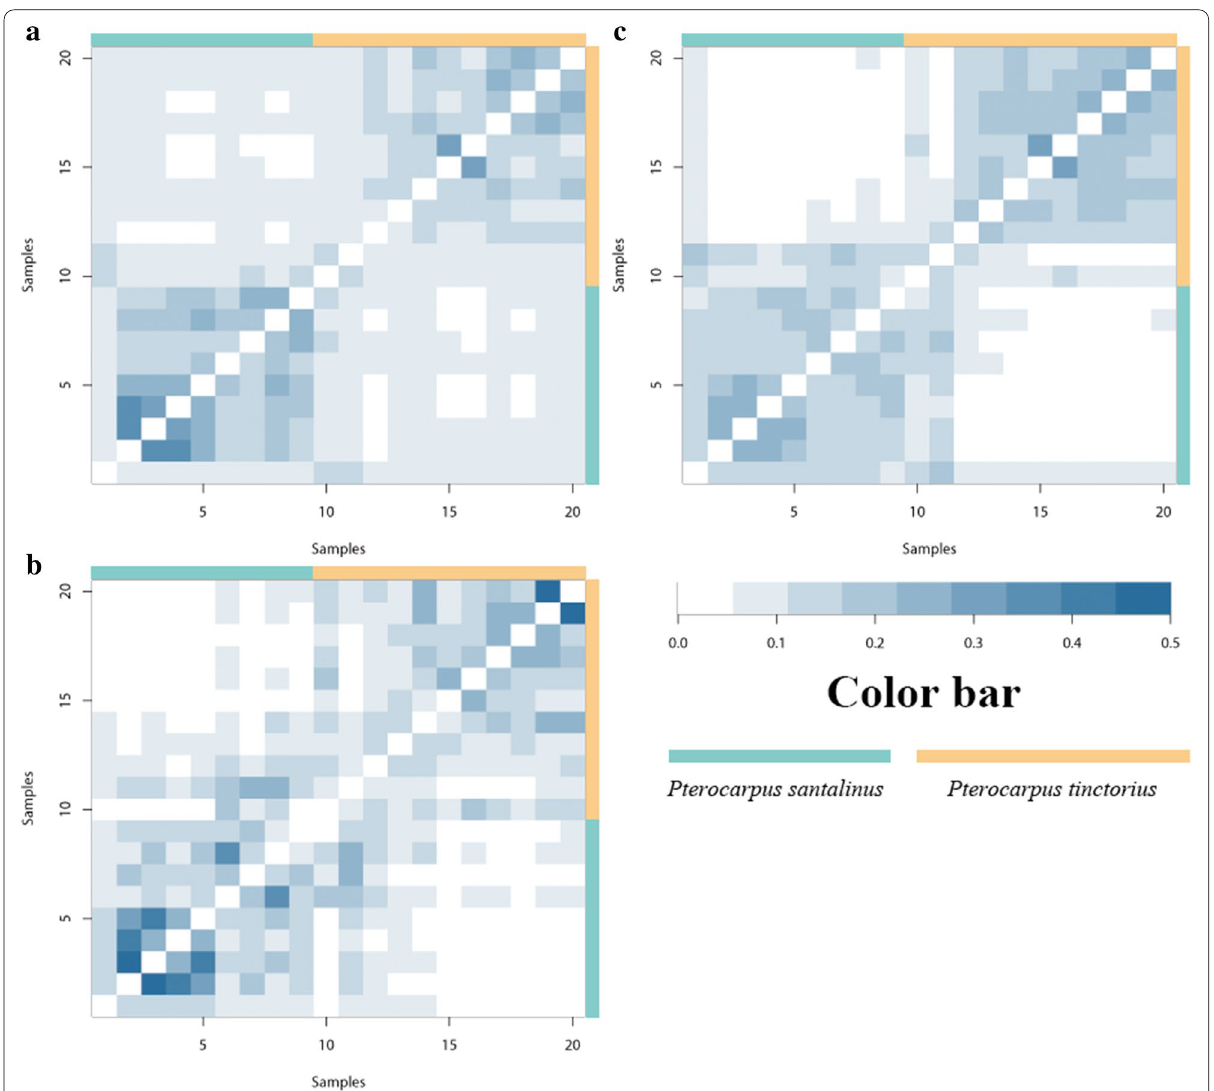
Fig. 4 Wood chips similarities for each of the data types independently compared to SNF fused similarity. HS–GC–MS data ( a ), DART–MS data ( b ), and SNF-fused similarity matrix ( c ). The first 9 samples are Pterocarpus santalinus , and the last 11 samples are Pterocarpus